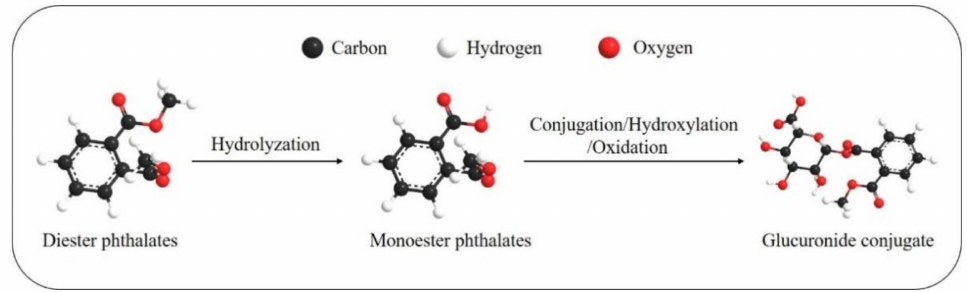
Figure 1. The metabolic pathway for